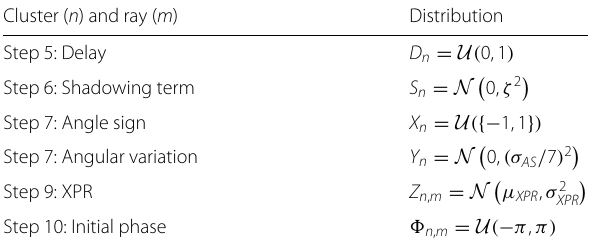
Table 1 Probability distributions of random variables used to generate small-scale parameters as specified by 3GPP [34, 35] Cluster ( n ) and ray ( m ) Distribution